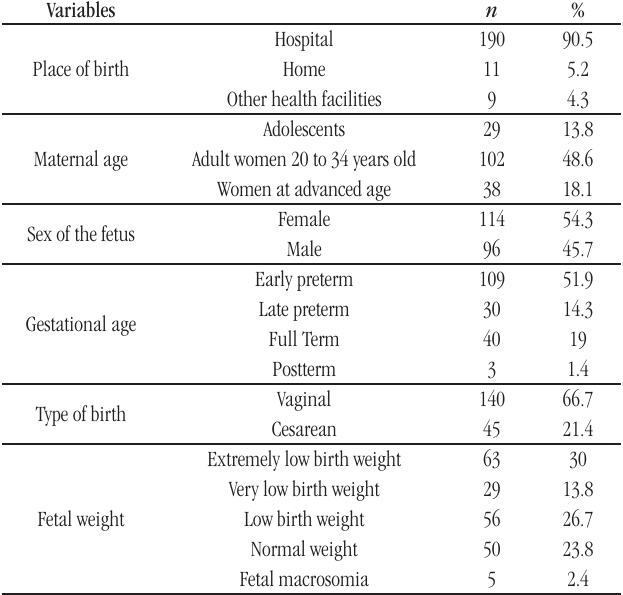
taBLE 1 − Sociodemographic and clinical characteristics of the sample Variables n